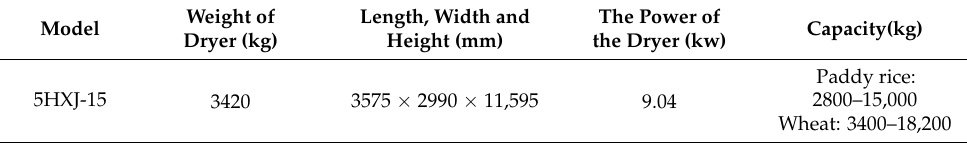
Figure 1. The scheme of the 15 ton batch type recirculating grain dryer: (1) the tempering section; (2) the drying section. Subfigures come from 5HXJ grain dryer instructions. Table 2. The dimensions of the 15 ton batch type recirculating grain